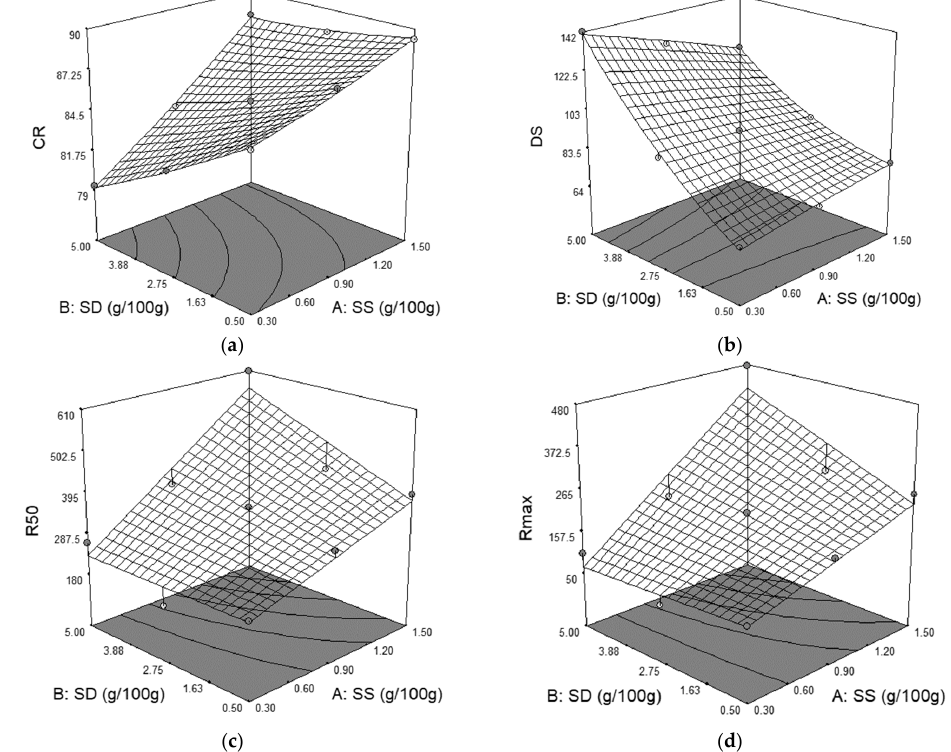
Figure 1. The graphical representations of the Farinograph and Extensograph parameters: ( 1a ) water absorption (WA); ( 1b ) degree of softening at 10 min (DS); ( 1c ) resistance to extension up to 50 mm (R 50 ); ( 1d ) maximum resistance to extension (R max ).